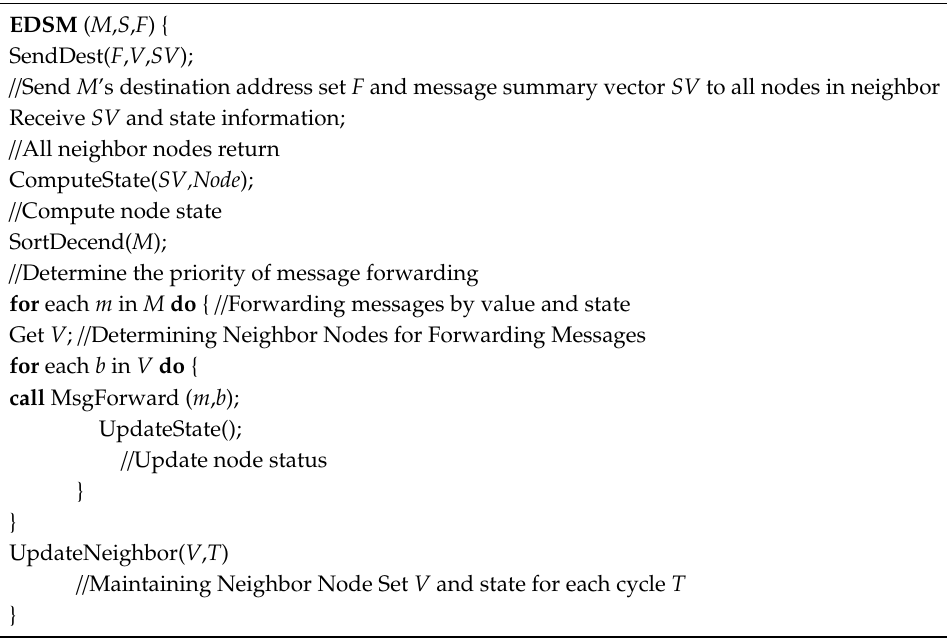
Algorithm 1. E ff ective Data Selection and Management